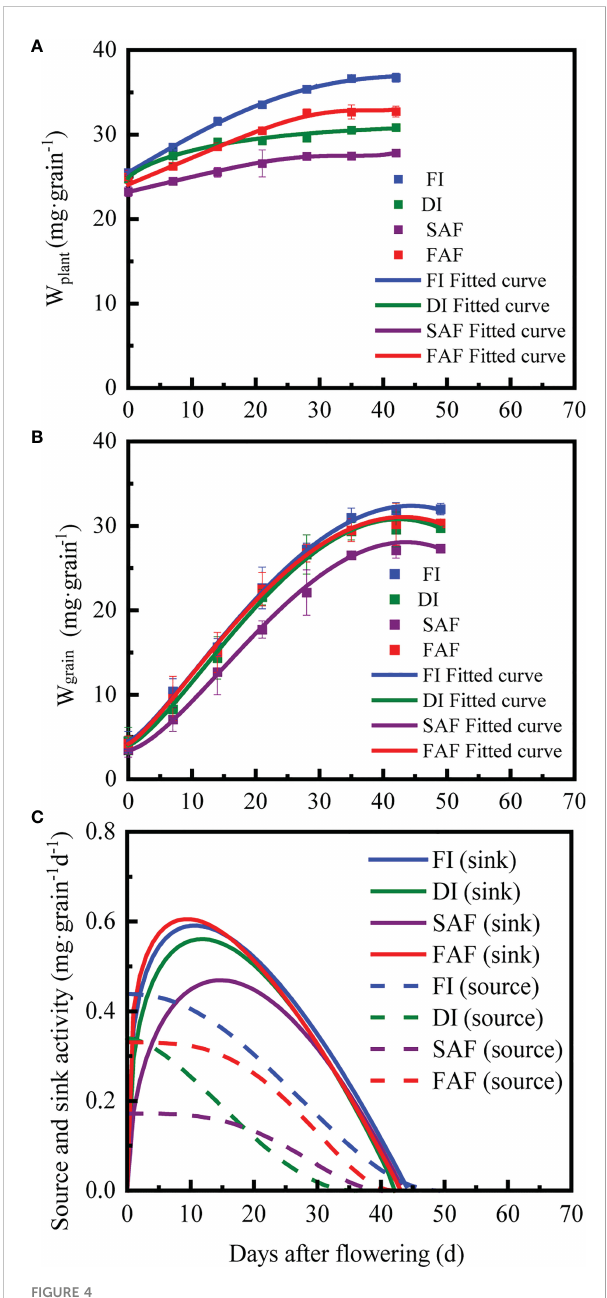
FIGURE 4 The observed mean value (W grain and W plant ) and fi tting curve of grain weight (A) and vegetable parts of shoots weight per grain (B) during grain fi lling stage in different irrigation strategies; dynamics of source-sink activity during grain fi lling stage (solid line indicates sink activity, dotted line indicates source activity) (C) . FI, the whole growing season fl ooding; DI, the whole growing season normal drip irrigation (soil relative moisture (RSM) was maintained in a range of 90 – 100%); SAF, pre-anthesis normal drip irrigation and post- anthesis water stress (the RSM was maintained in a range of 80 – 90% after anthesis); FAF, pre-anthesis normal drip irrigation and post-anthesis fl